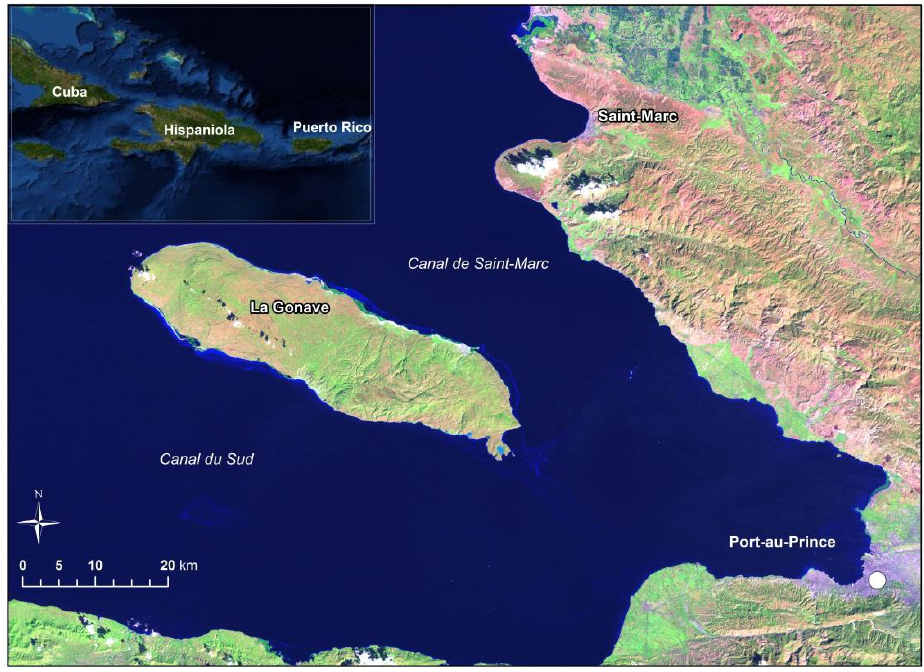
Figure 1. Island of La Gonave (18°50'0''N, 73°5'0''W), Haiti, using Landsat 5 TM imagery, positioned in the Gulf of Gonave between Canal de Saint-Marc and Canal du Sud opening